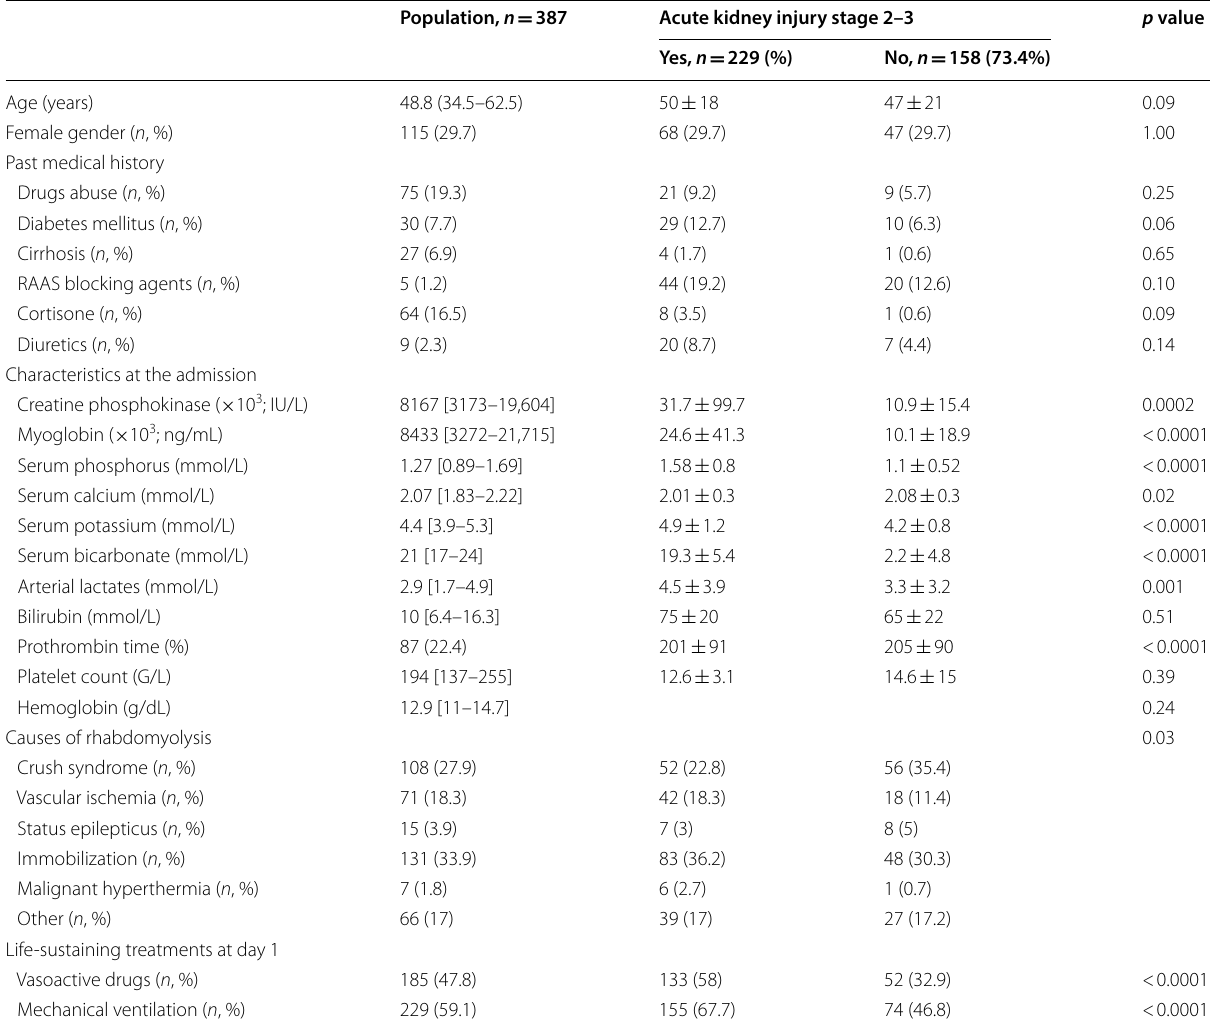
Table 1 Characteristics of 387 patients with severe